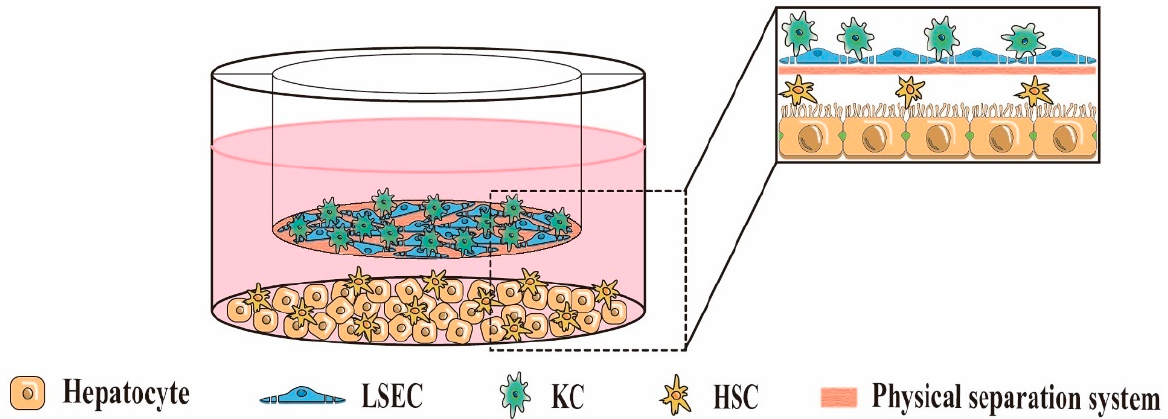
Figure 3. An example of an indirect 3D cell co ‐ culture liver model.